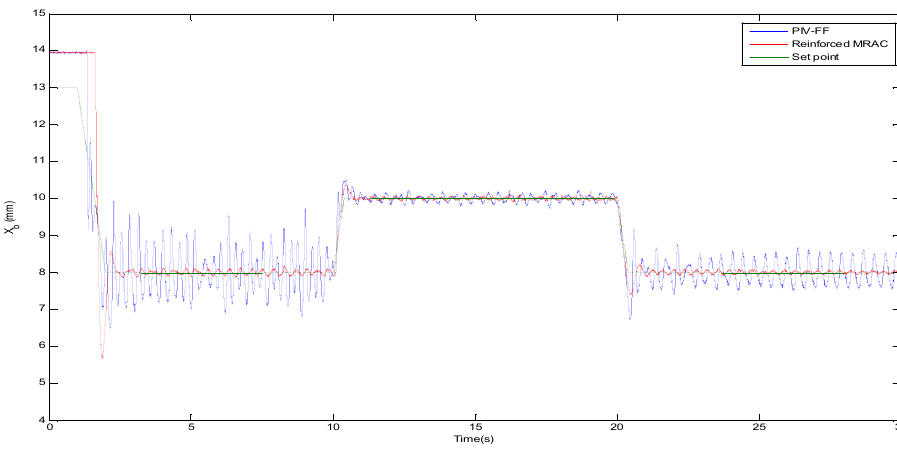
Figure 9. Performance validation.